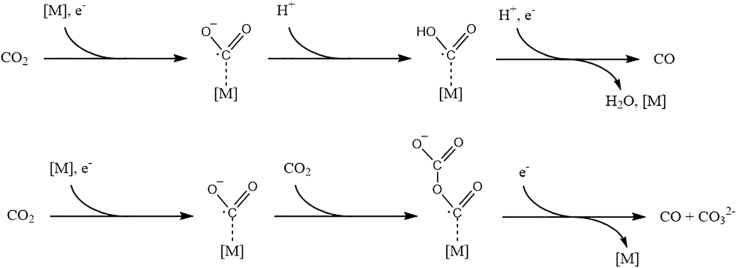
Proposed reaction mechanisms for the electrocatalytic reduction of CO2 to COTop: in the presence of water (Ma et al., 2018), below: in aprotic media (Gennaro et al., 1996a, Gennaro et al., 1996b).